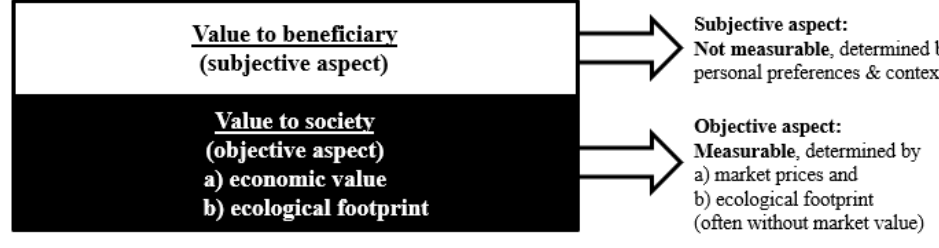
Fig. 2. The two aspects of value. Source: Author’s figure Ecological footprints differ significantly between countries and different social and income groups ([34]). However, it is undisputed that globally, the current ecological footprint significantly exceeds the planet’s capacity to replenish [32], [35]. As an example, the most recent Circularity Gap Report 2022 states that since 2015 “… the global economy consumed 70% more than what the Earth can safel y replenish”